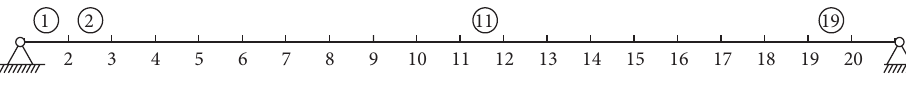
Figure 4: A simple supported beam (Example